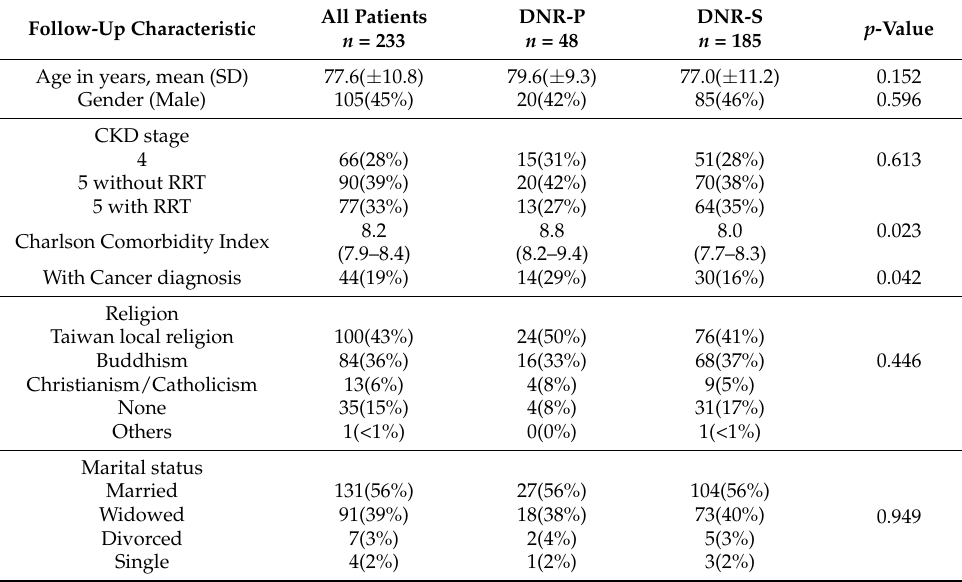
Table A1. Follow-up clinical characteristics in patients with advanced kidney disease